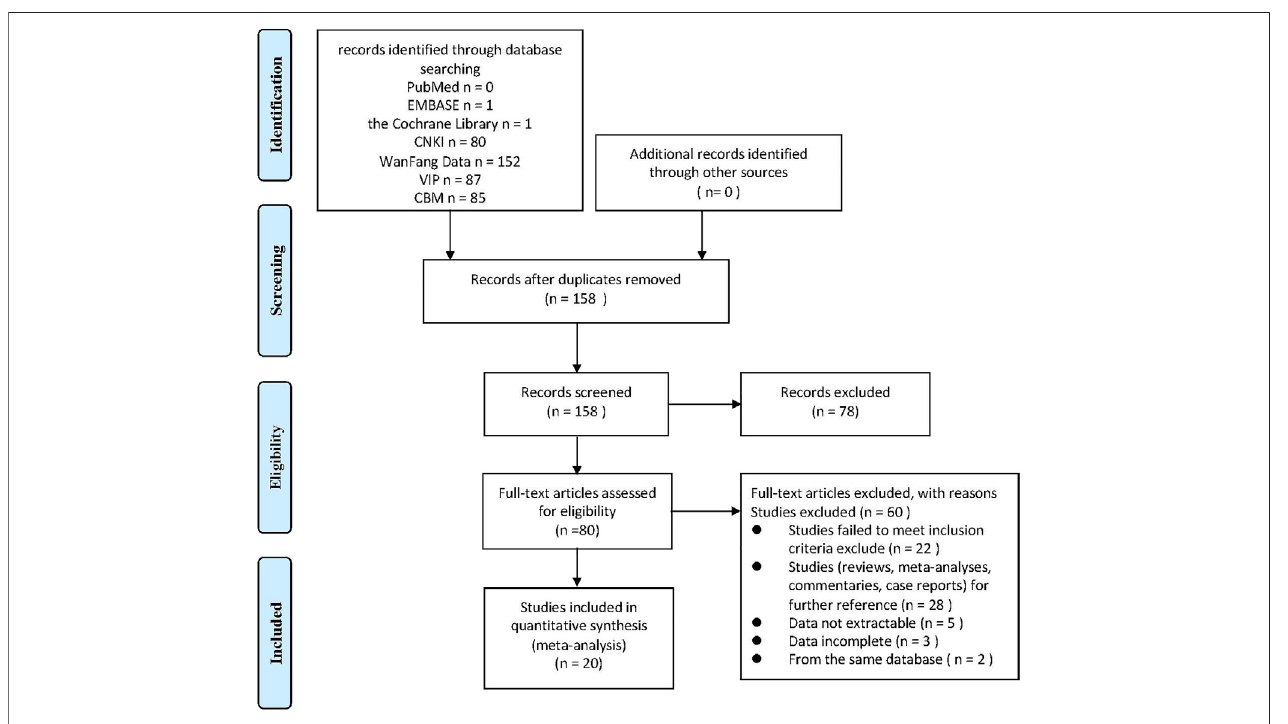
FIGURE 1 | Flowchart of article selection